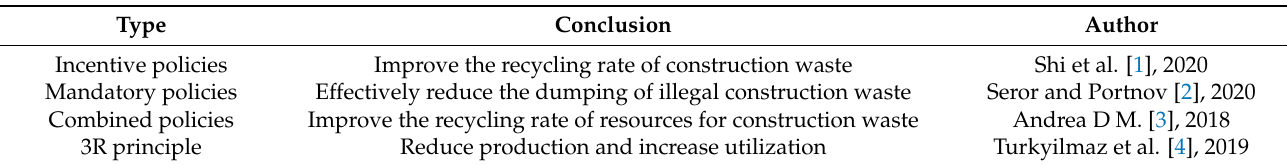
Table 1. The relevant policy